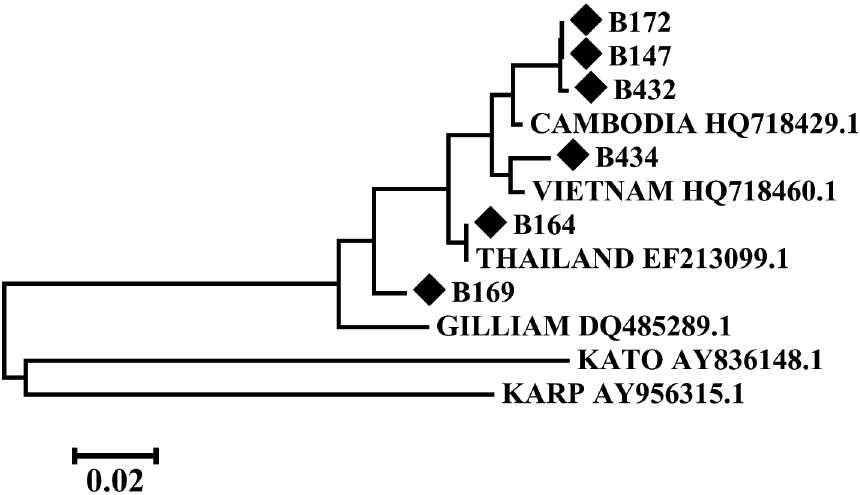
Fig 3. Phylogenetic analysis of scrub typhus strains by Maximum Likelihood Method using MEGA6. The tree is drawn to scale, with branch lengths measured in the number of substitutions per site. There were a total of 602 positions in the final dataset. The six sequences obtained (shown in bullets) were compared to Gilliam, Karp and Kato prototype strains and to the closest matching sequences obtained by BLAST analysis.